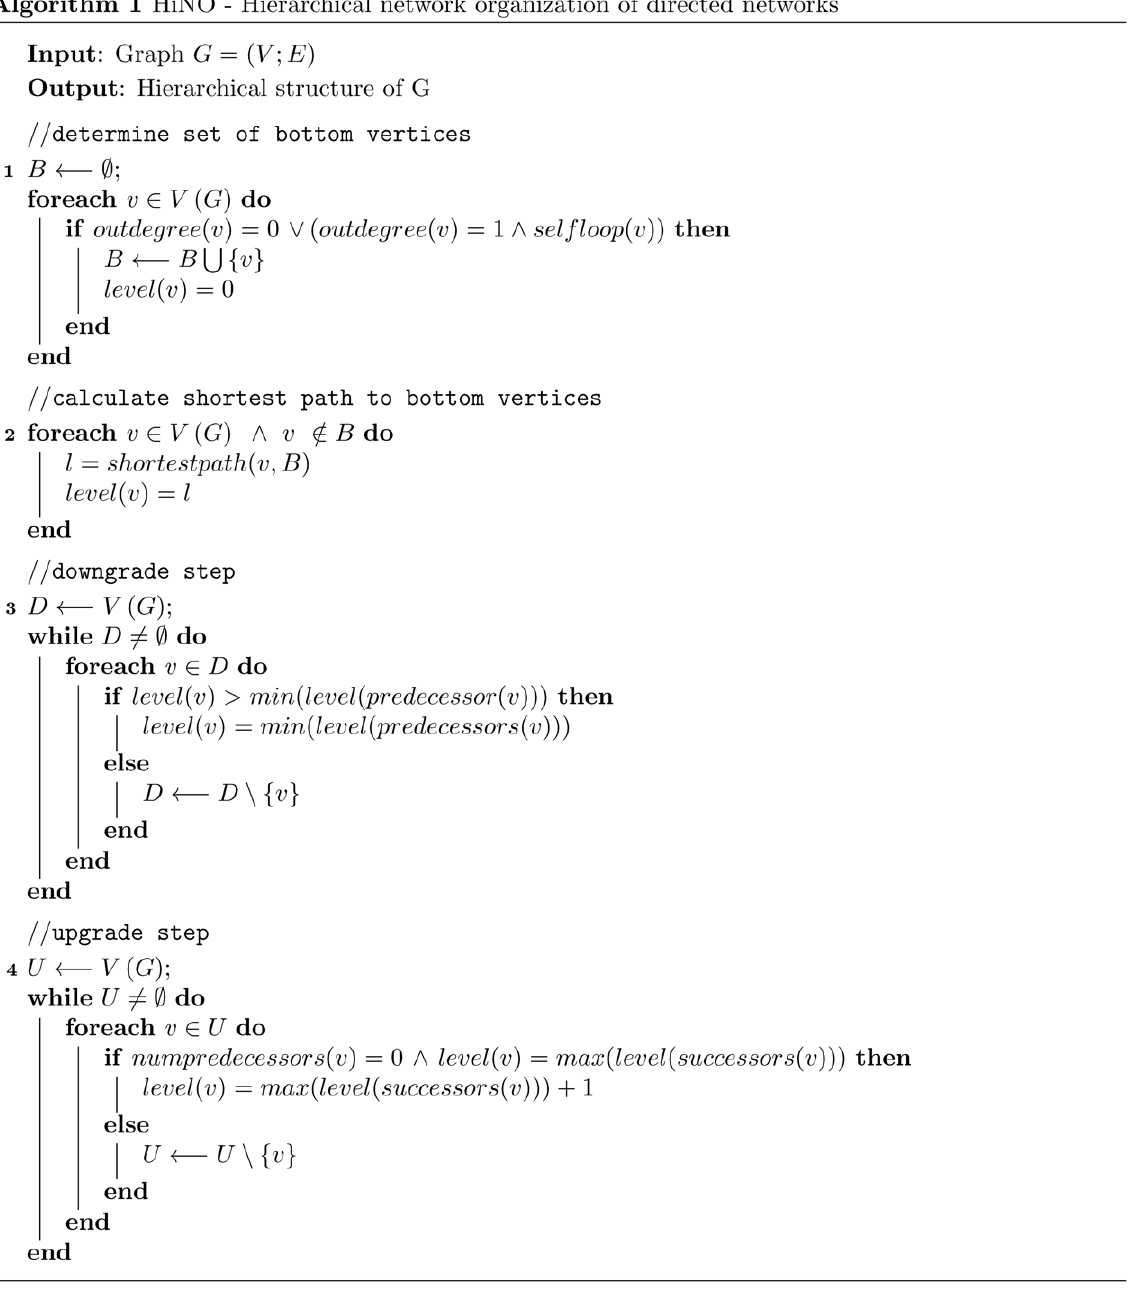
Figure 3. Pseudocode of the algorithm. Pseudocode for extracting the hierarchical organization of directed networks.